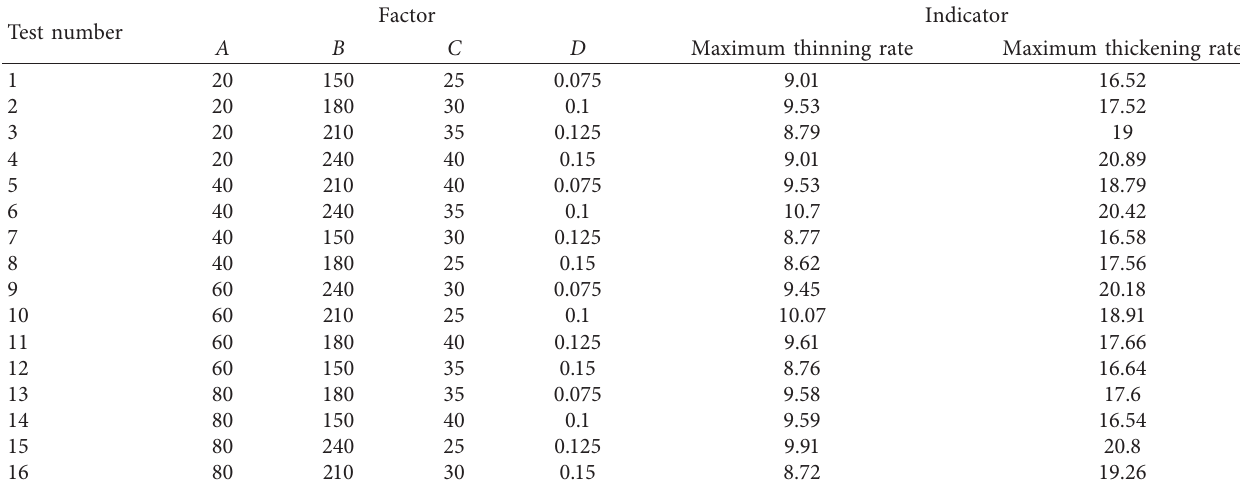
Table 7: Orthogonal inner table.